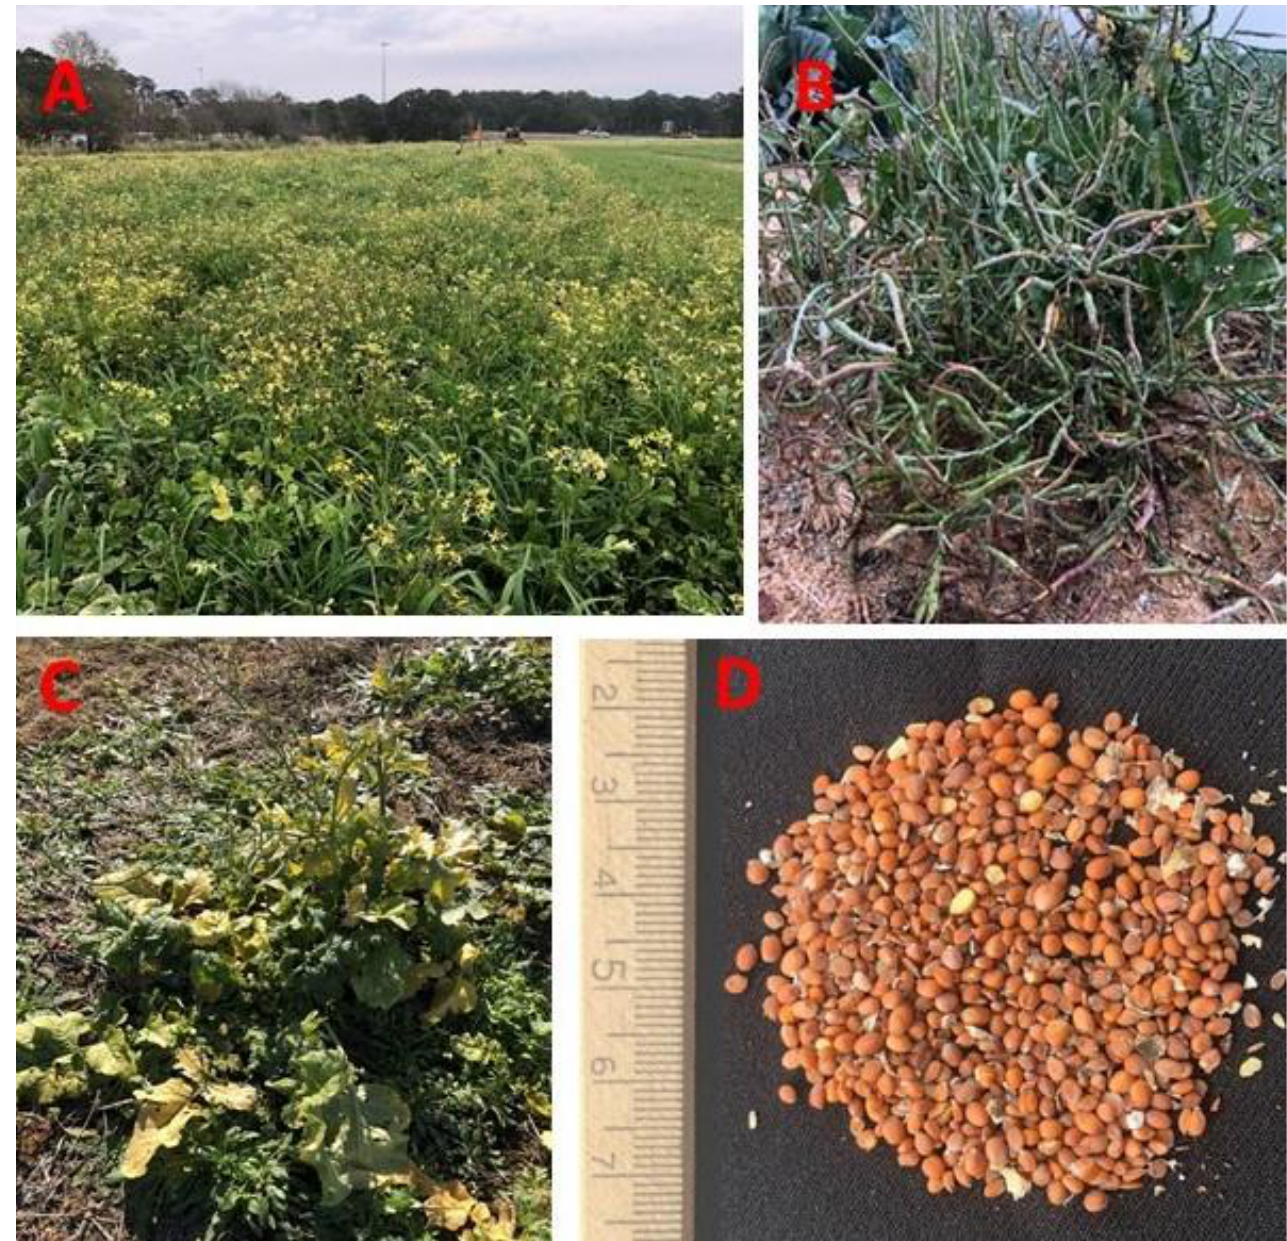
Figure 1. Wild radish ( Raphanus raphanistrum L.) is a ubiquitous weed in southern Georgia. It can be seen growing profusely in and around the border of the fields ( A ). A single plant can produce a large number of pods ( B ), showing yellowing symptoms ( C ), and seeds were extracted from dried pods (siliques) ( D ).